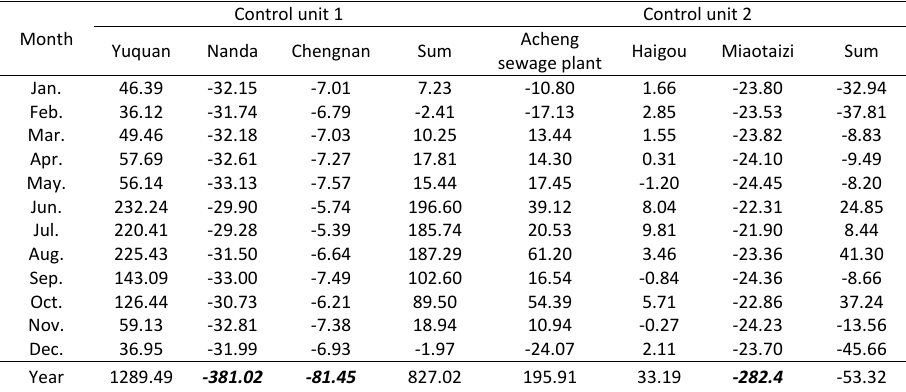
Fig. 9: Annual actual water environment capacity of COD cr and NH 3 -N at each outlets and control units